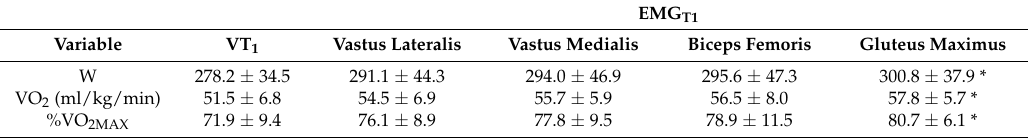
Table 2. Mean values of the power output (W), VO 2 , and %VO 2MAX obtained at the first electromyographic threshold (EMG T1 ) and at the first ventilatory threshold (VT 1 ). All values are expressed as mean ±